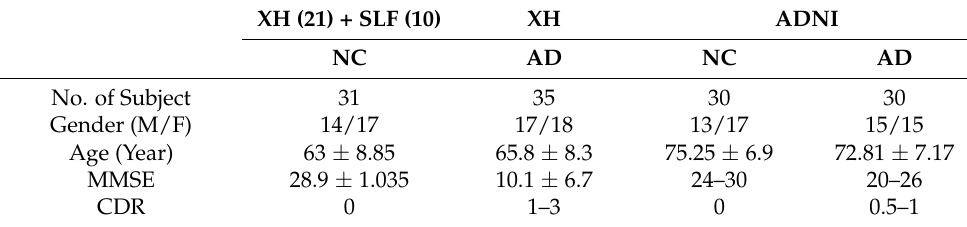
Table 1. Demographic and neuropsychological information of normal controls (NC) and Alzheimer’s disease (AD) patients related to gender, age, mini-mental state examination (MMSE) and clinical